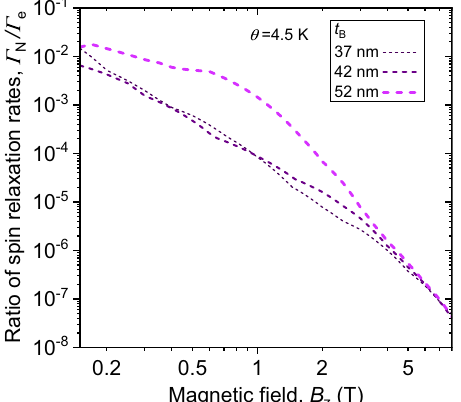
Fig. 4 Ratio of nuclear and electron spin relaxation rates. Γ N / Γ e as a function of magnetic fi eld B z is plotted by taking linear interpolations of the logarithms of experimentally measured nuclear and electron spin relaxation rates. The results are shown for individual quantum dots in three samples with different tunnel barriers t B = 37, 42 and 52